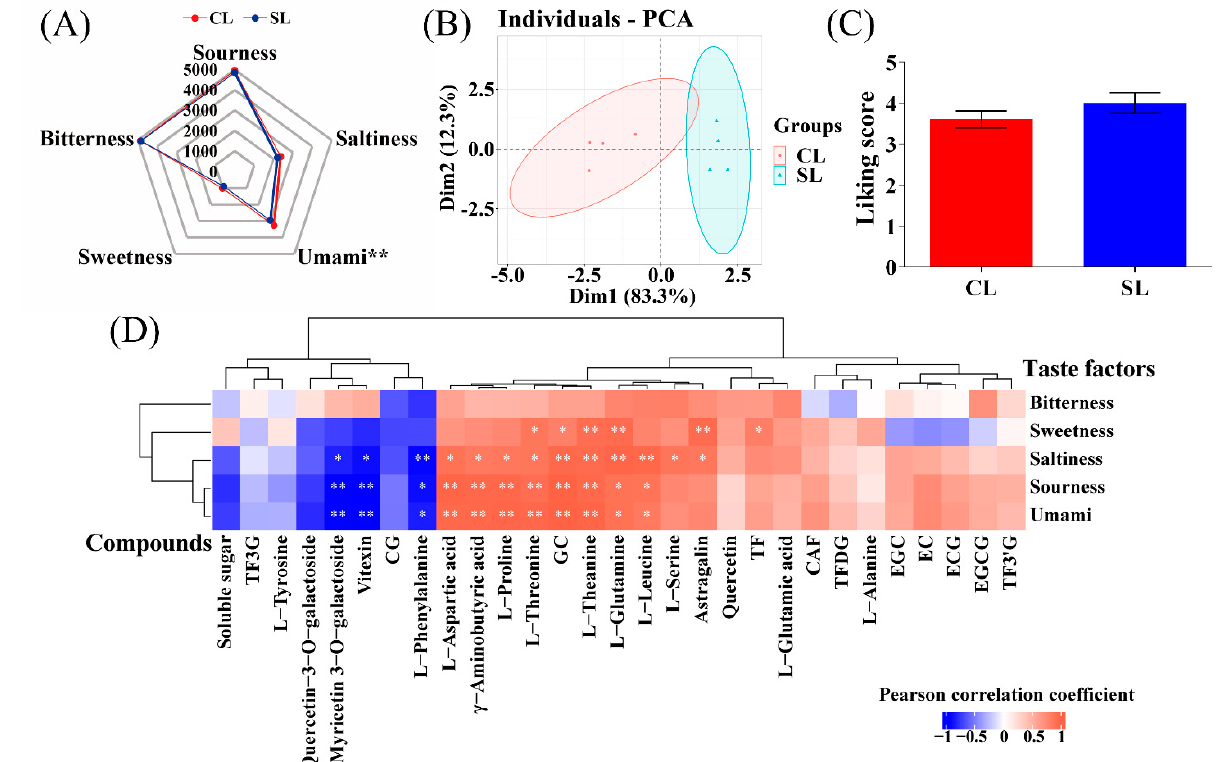
Figure 4. Analysis of the taste of oolong tea. ( A ) Radar map of electronic tongue dataset. ( B ) Principal component analysis (PCA) score chart of taste factor response value. ( C ) Sensory evaluation. ( D ) Heatmap of the correlation between the content of taste components and the response values of taste factors of the electronic tongue (CL, combined leaf; SL, separated leaf; **, p < 0.01; *, p < 0.05).